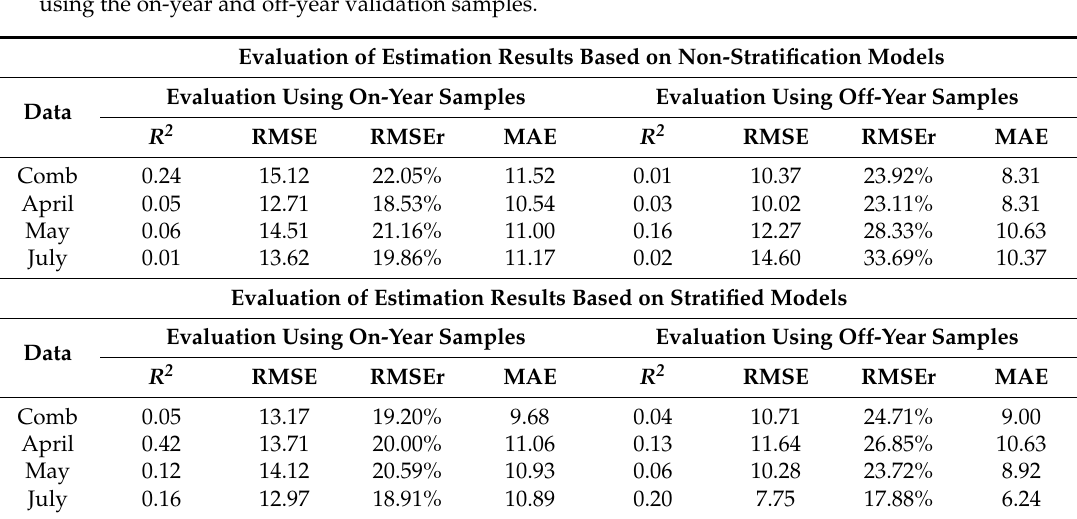
Table 9. Evaluation of estimation results based on non-stratification- and stratification-based models using the on-year and off-year validation